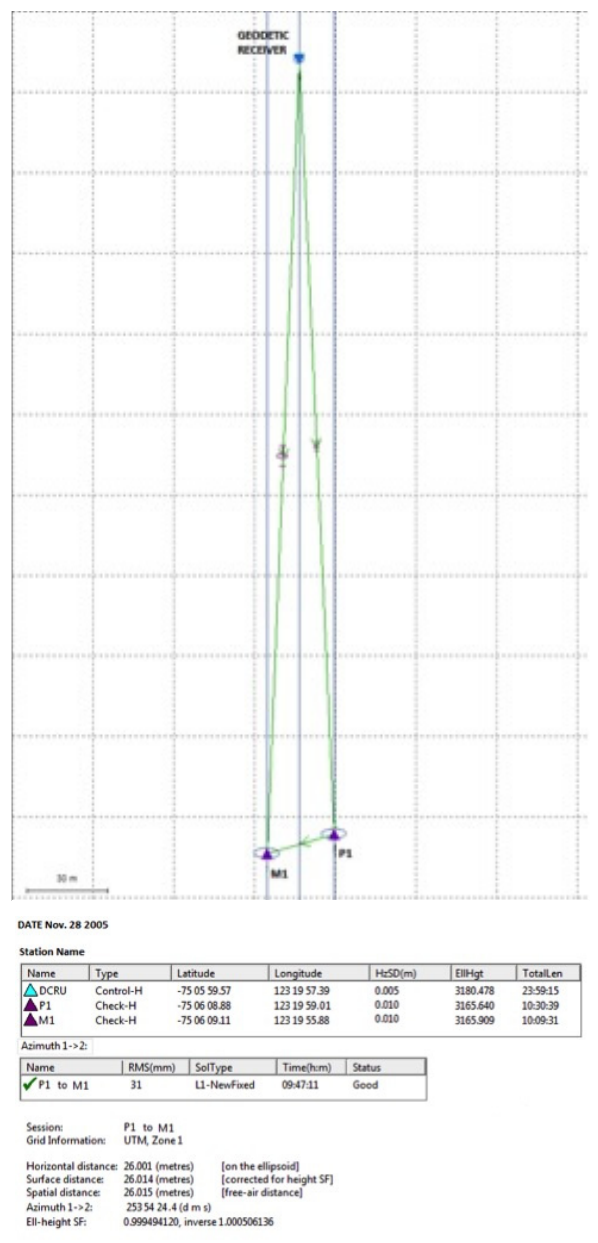
Figure 4. Graphic and computer results of a GNSS survey carried out in Nov. 28, 2005. P1 and M1 indicate geographic positions of the pillar and azimuth mark,